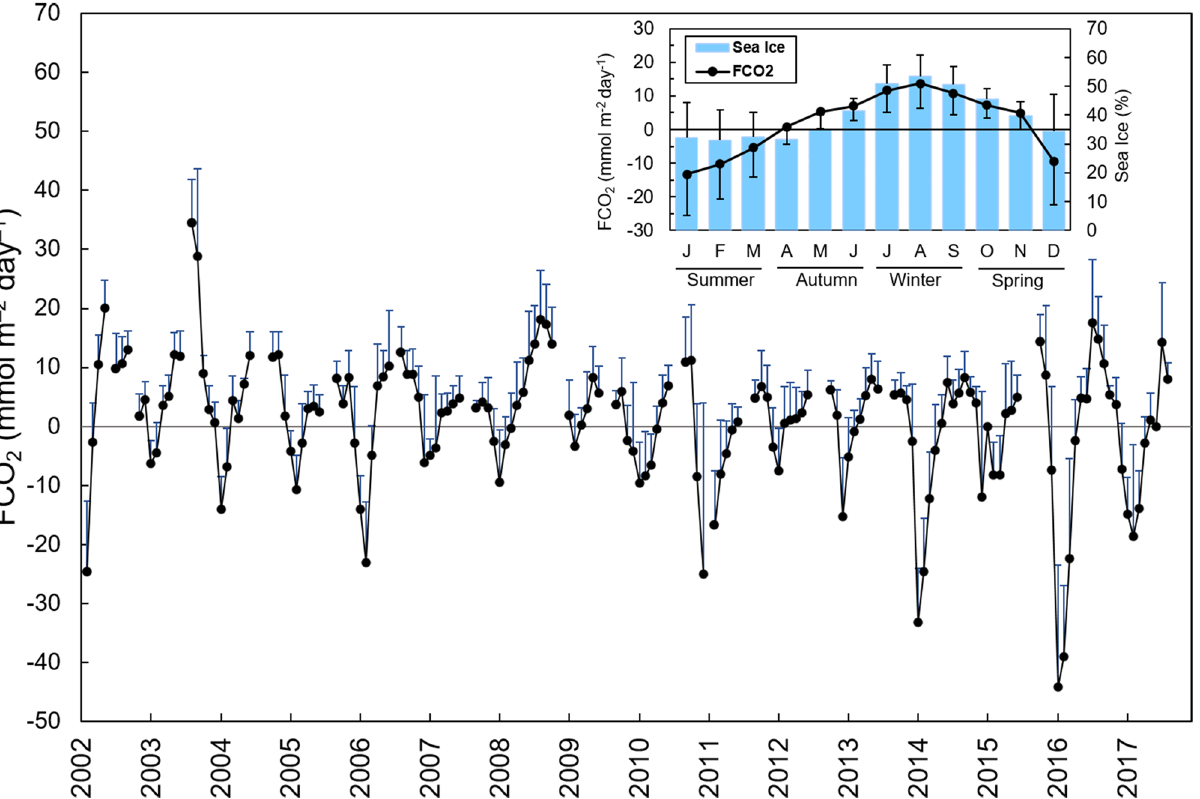
Figure 1. A correct version of the original Figure 5 . Monthly averages of net sea-air CO 2 fluxes (FCO 2 ) in the Gerlache Strait from January 2002 to December 2017 with an inset showing the variability throughout the year to characterize the seasonal cycle of FCO 2 and the percentage of sea ice cover (filled blue bars). The gaps are from years when there was no winter sampling in the region. The blue bars oriented upwards are the standard deviations from the respective monthly averages, as are the black bars in the inset. Positive FCO 2 values represent the outgassing of CO 2 to the atmosphere, whereas negative FCO 2 values represent CO 2 uptake by the